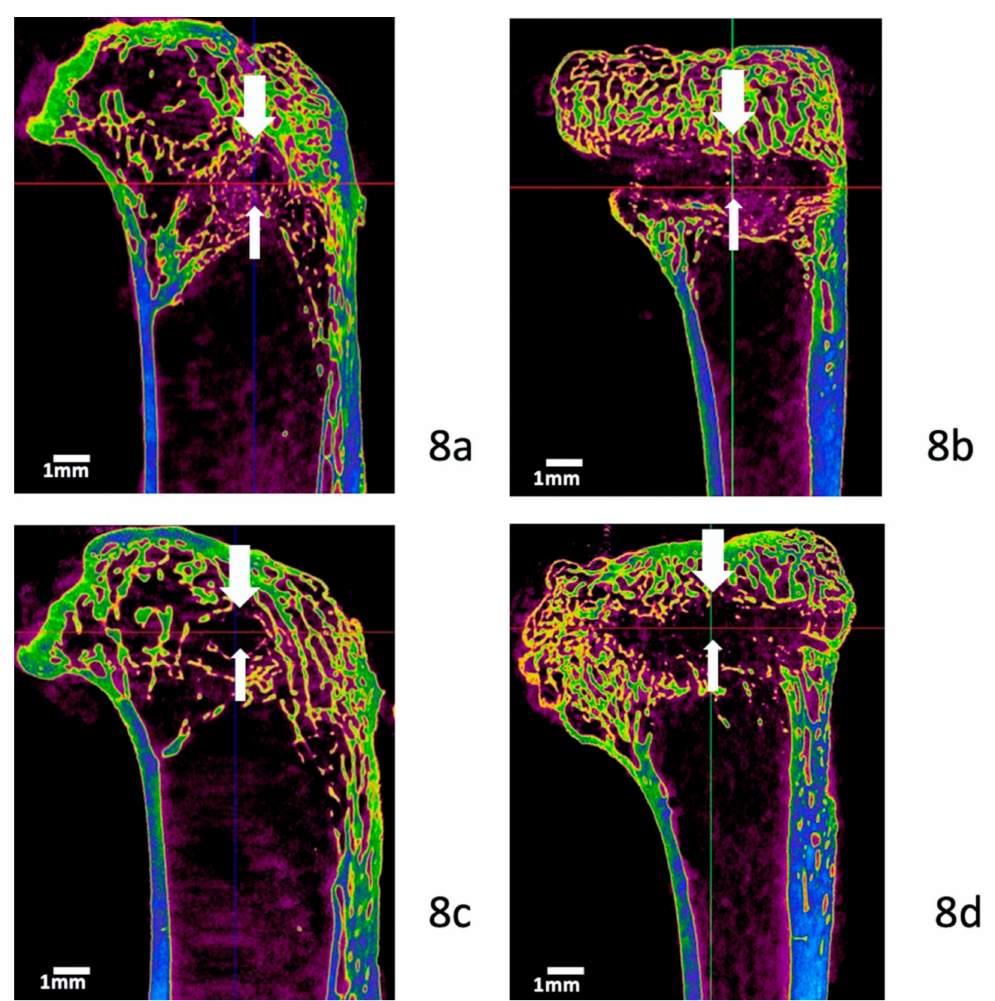
Figure 8. Microcomputed tomography (Micro-CT) examination showed bone formation. Micro-CT shows tendon graft and bone tunnel in an 8-week specimen from the control group. ( a , b ) Bone tunnel obliteration with new bone ingrowth was identified in sagittal and coronal views after enzyme treatment ( c , d ). Prominent bone ingrowth was observed in both tunnel orifices. Line arrow marks the tendon graft, and block arrows indicate the bone tunnel. (scale bar: 1 mm).